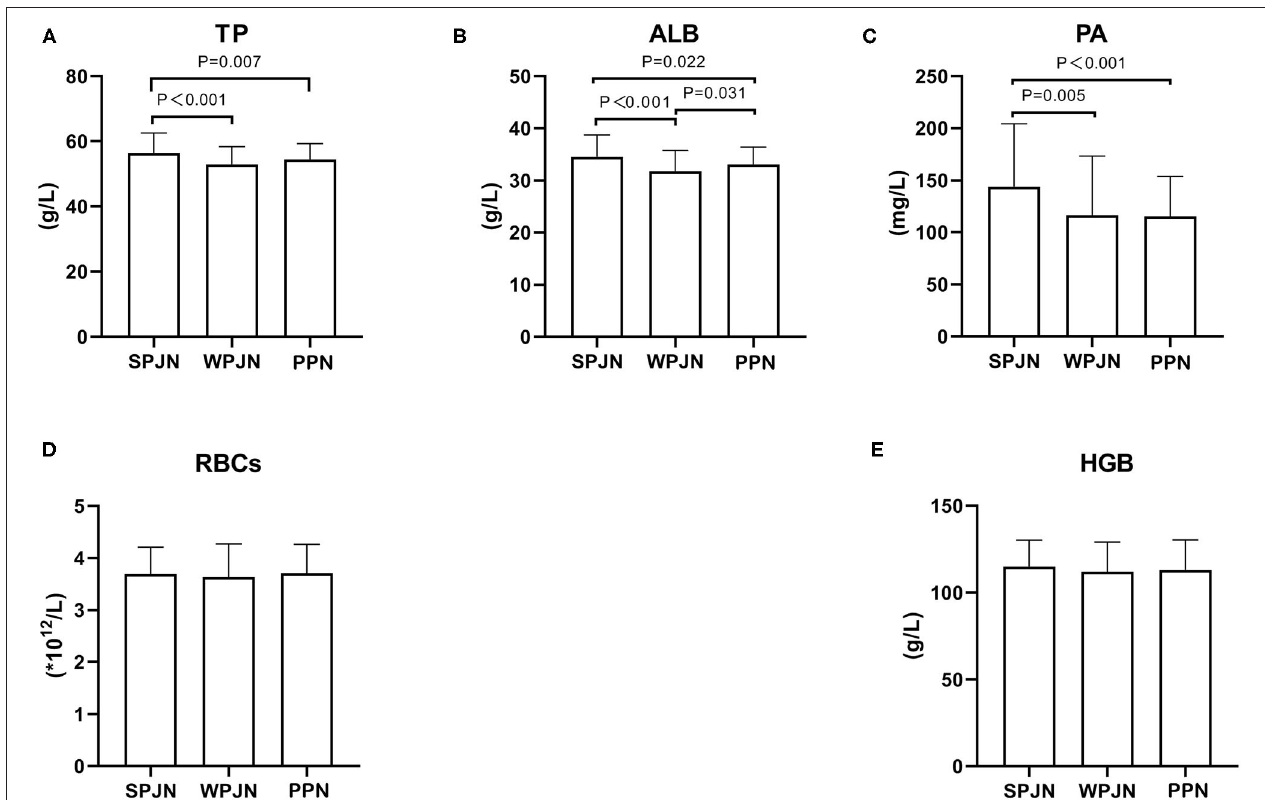
FIGURE 2 | Nutrition indexes. Patients in the SPJN group had remarkably higher serum TP, ALB, PA than those in the WPJN group and in the PPN group (A–C) . Moreover, the ALB level after operation in the PPN group was notably higher than that in the WPJN group (B) . However, the RBCs and the HGB among the three groups (D,E) were not statistically significant.